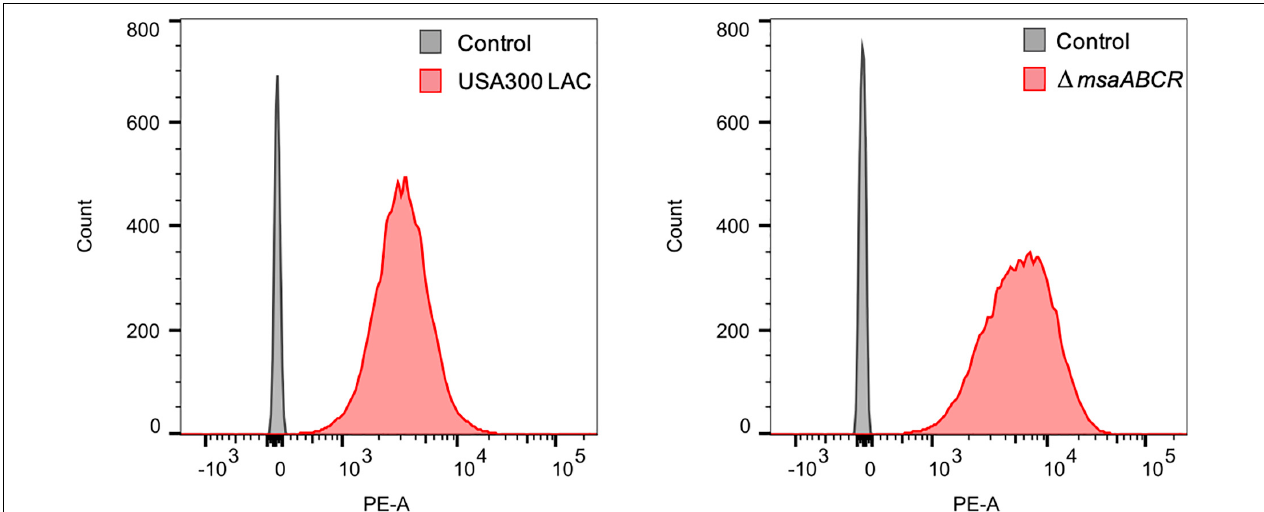
FIGURE 8 | Measurement of gentamicin uptake. The conjugation of gentamicin with Texas Red fluorescence (Gen: TR) in a 30:1 molar ratio was made in anhydrous N , N -dimethylformamide. The mixture was gently rotated for 3 days at 4 ◦ C. The washed stationary-phase cells were incubated with Gen: TR for 3 h at 37 ◦ C with continuous shaking. After incubation, the cells were washed twice, resuspended in 500 µ l PBS, and evaluated using flow cytometry with excitation/emission maxima at ∼ 595/615 nm. The median values for PE-A were measured using FlowJo software. The mean of median values for the three independent experiment were 3589 ± 538 for USA300 LAC and 5356 ± 1021 for the (cid:77) msaABCR